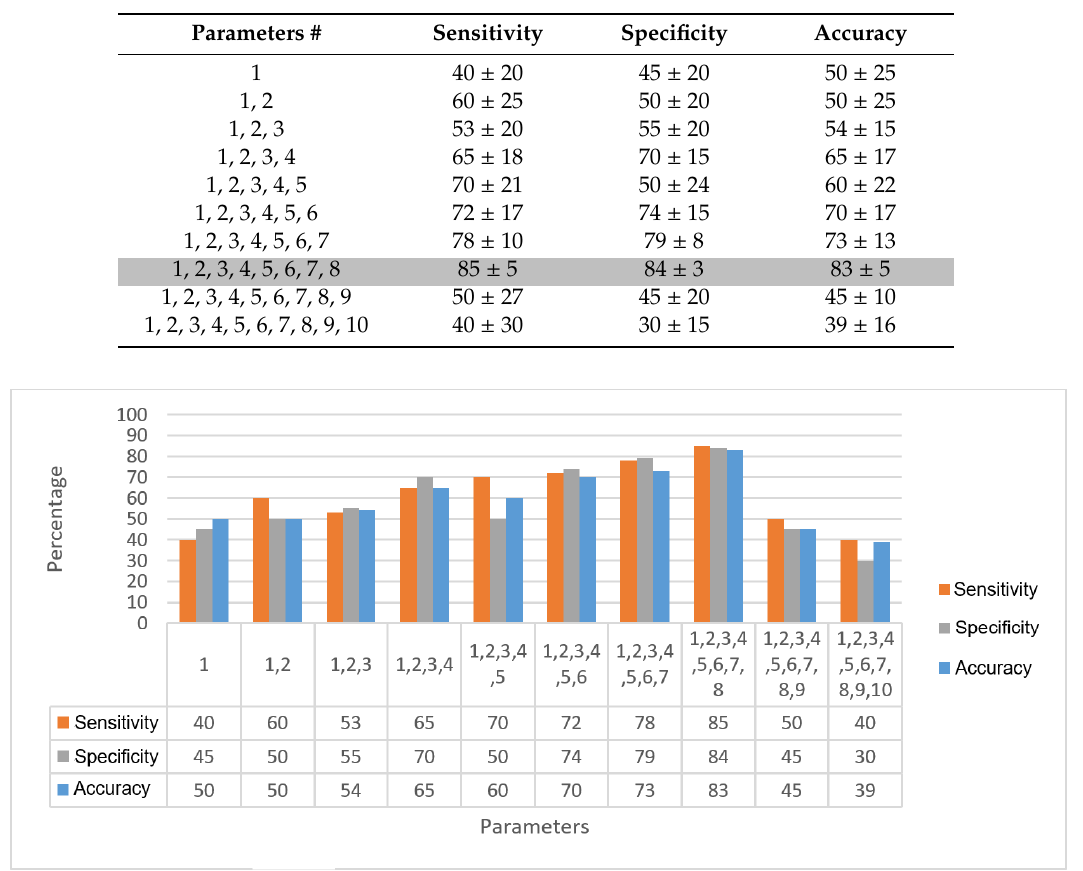
Figure 21. Graphical analysis of parameters vs. statistical results.